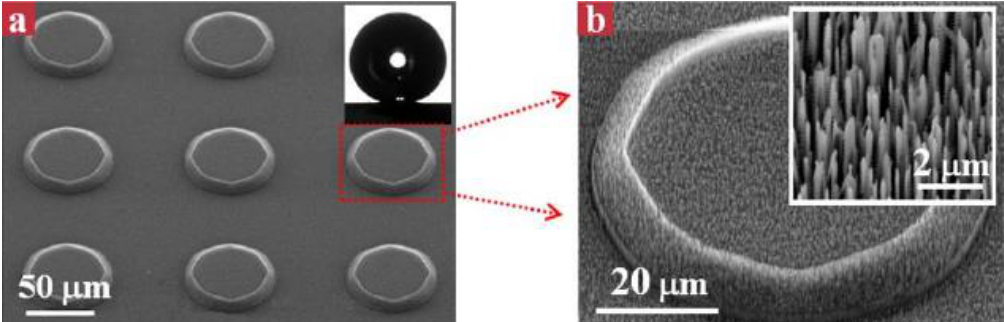
Figure 5. Condensation frosting on hierarchical nanograssed superhydrophobic surfaces. ( a ) Top view scanning electron micrograph and ( b ) close-up image of a single nanograssed micro-truncated cone. The image is reproduced from ref. [96] under CC BY 3.0 license for unrestricted use, redistribution and modification of published research. In principle, the frost spreading is successfully accelerated or decelerated by inserting or removing the active sites (in Figure 5 approximated with each nanograssed cone) [87] and deliberately triggering an early freezing event to minimize the size of incipient nuclei [78] i.e., via appropriate laboratory micropatterning.